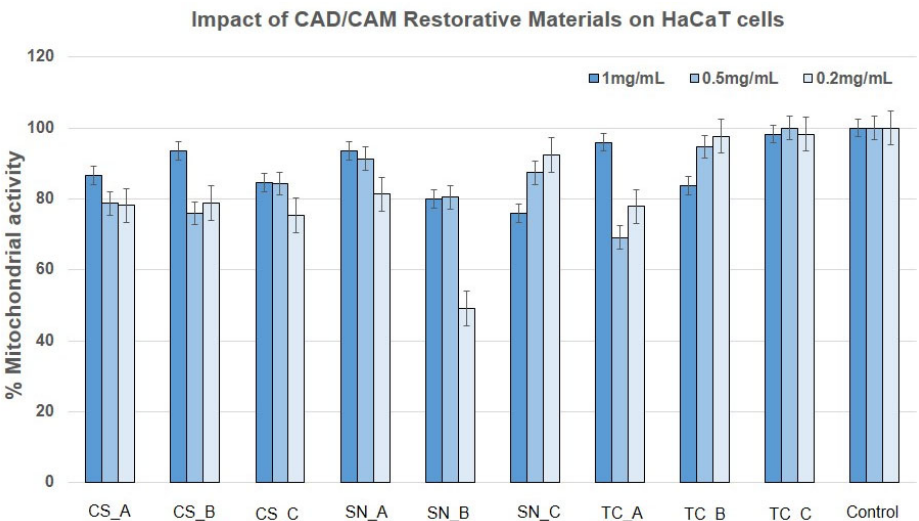
Figure 7. Mitochondrial activity percentage of HaCaT cells, after treatment with nonexposed/exposed to acidic artificial saliva of CAD/CAM restorative materials powders.